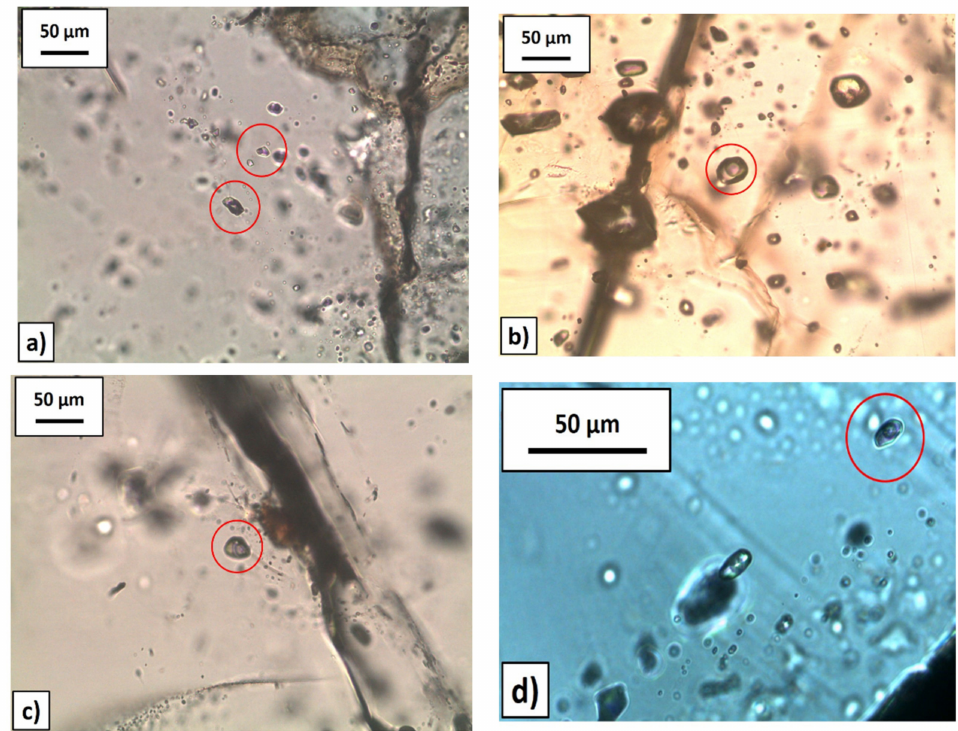
Figure 9. Aqueous-carbonic fluid inclusions: ( a ) Sample 3N1.6a and b predominantly CH 4 phase. ( b ) Sample 3N2.1c predominantly CO 2 phase. ( c ) Sample SHS1.3a predominantly CO 2 phase. ( d ) Sam- ple SHS2.5b predominantly CO 2